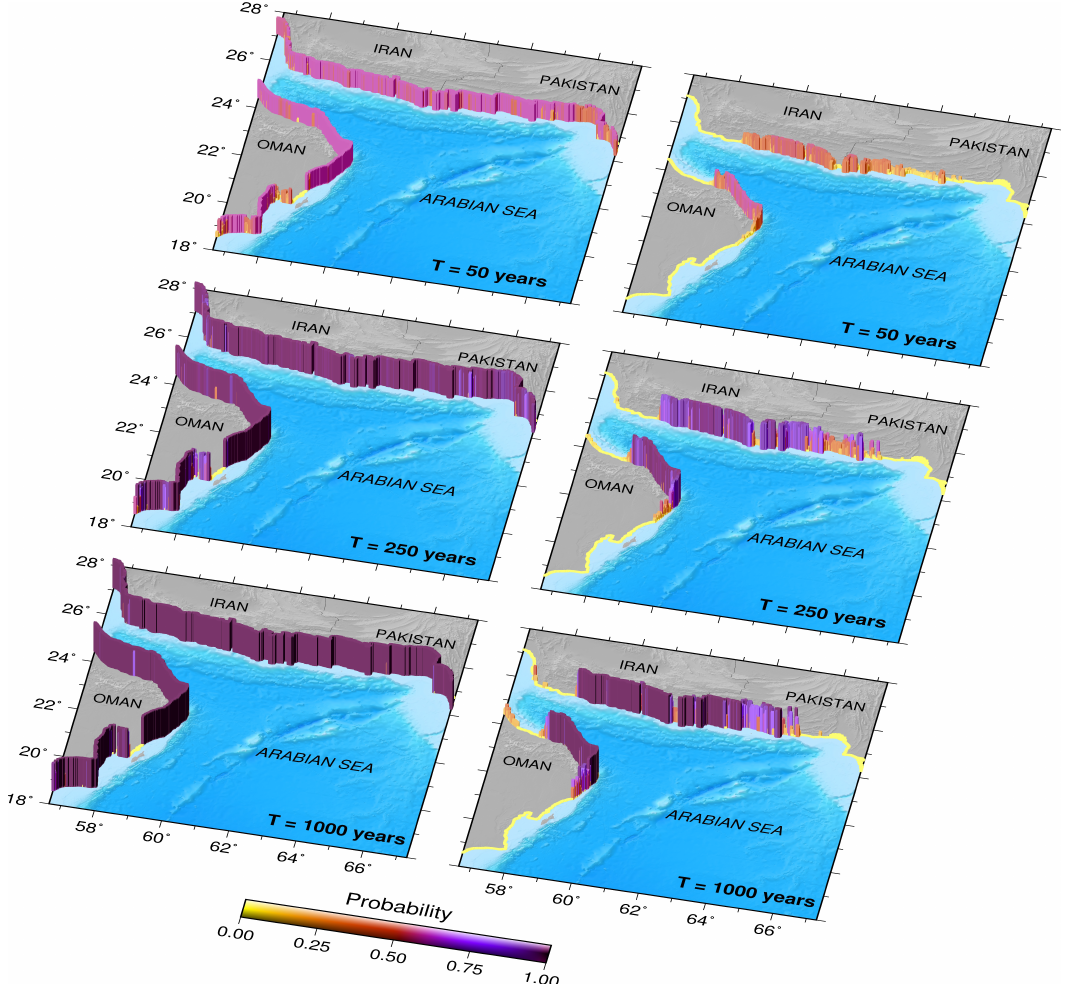
Figure 11. Probability of tsunami wave height exceeding 0.5 m (left panel) and 3 m (right panel) for time periods of 50, 250 and 1000 years along the coastlines of Iran, Pakistan and Oman (modified after